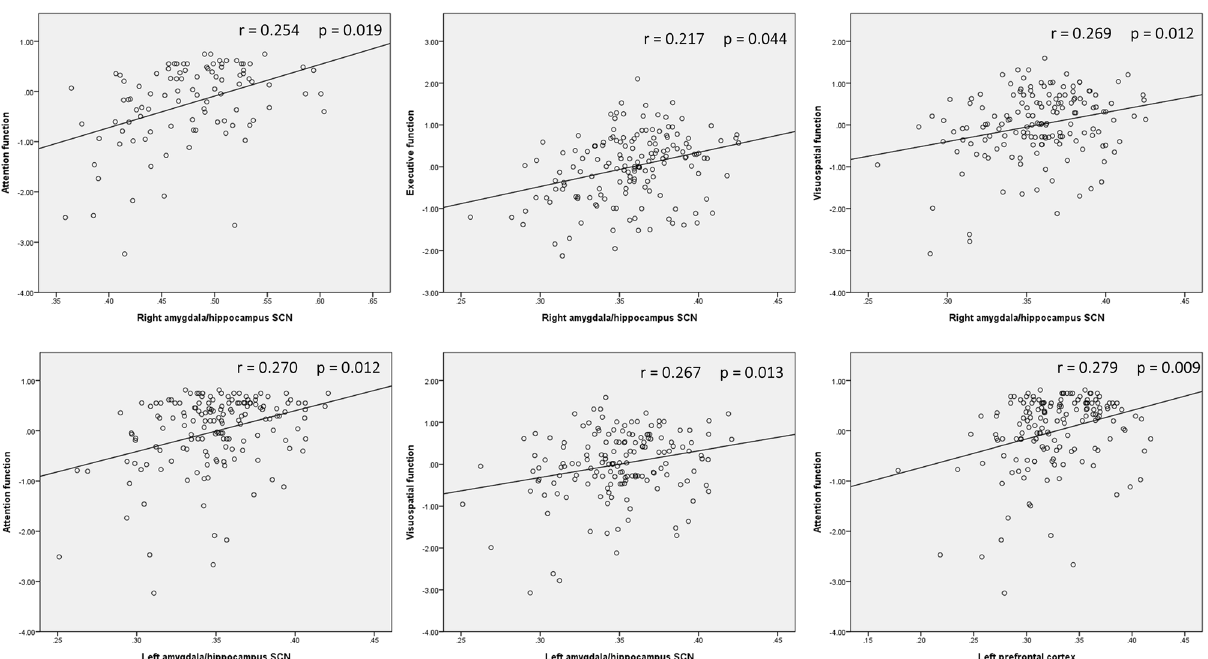
Figure 2. Correlation between cognitive performance and ROIs. The GMV of the SCN constructed from the right amygdala/hippocampus is correlated with with attention, executive, and visuospatial domains. The GMV of the SCN constructed from the left amygdala/hippocampus is correlated with attention and visuospatial domains. The GMV of the left prefrontal cortex is correlated with attention